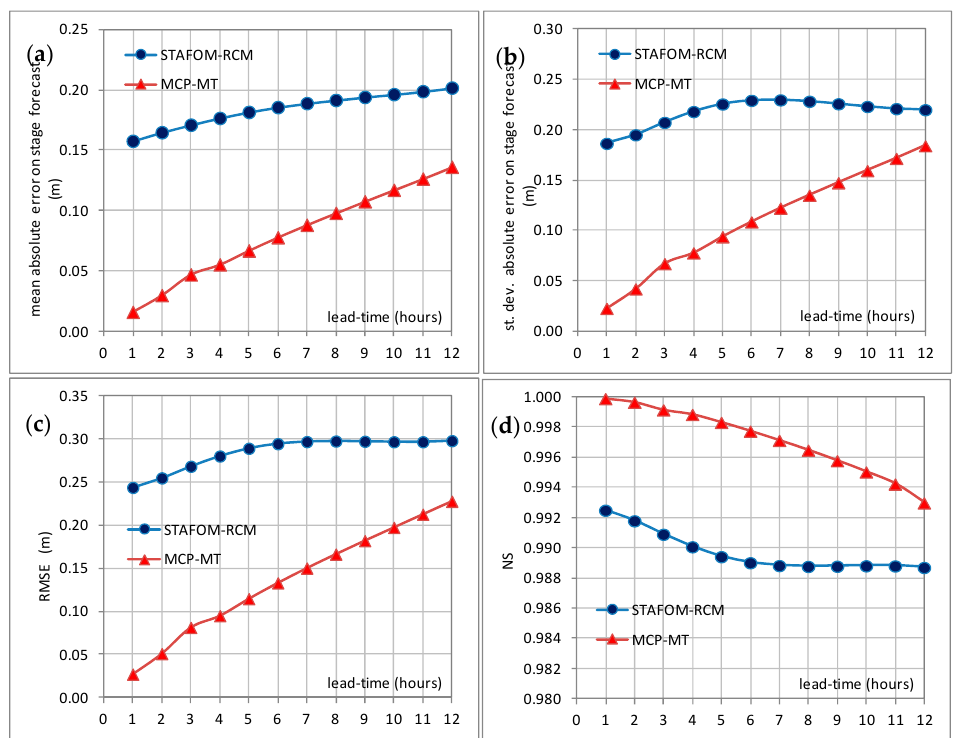
Figure 4. Godavari River, reach 1 (Bhadrachalam ‐ Polavaram): performance measures for the deterministic forecast and the MCP ‐ MT application for lead ‐ times from 1 to 12 h: ( a ) mean of the absolute error on stage forecast; ( b ) standard deviation of the absolute error on stage forecast; ( c ) root mean square error, RMSE; and ( d ) Nash–Sutcliffe coefficient, NS. The measures are computed for the entire database.